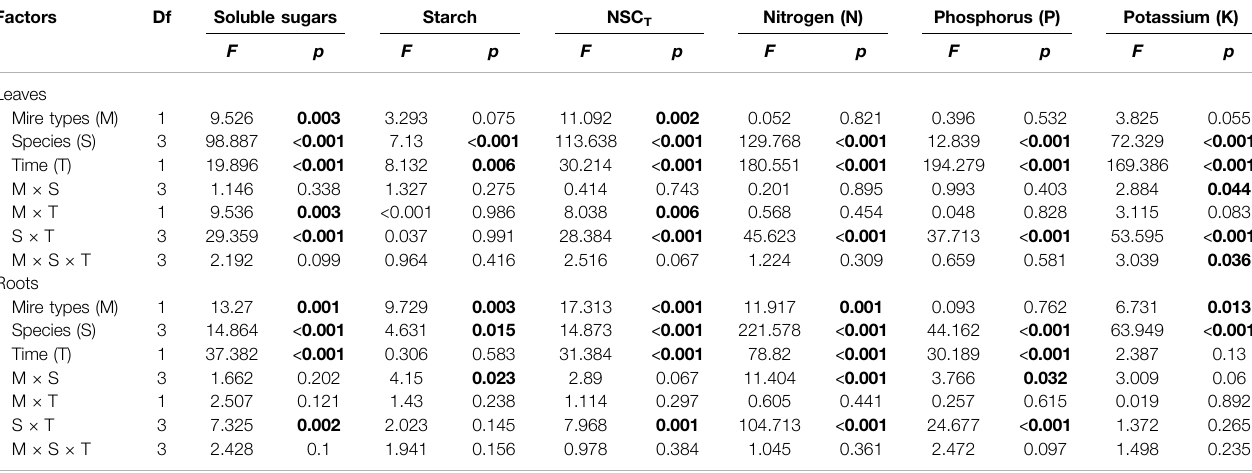
TABLE 1 | Effects of mire types, species, sampling time, and their interactions on concentrations of NSCs (i.e., sugars, starch, and NSC T ) and nutrients (i.e., N, P, and K) in plant leaves and roots, tested with three-way nested ANOVAs. F and p values are given. Factors Df Soluble sugars Starch NSC T Nitrogen (N) Phosphorus (P)